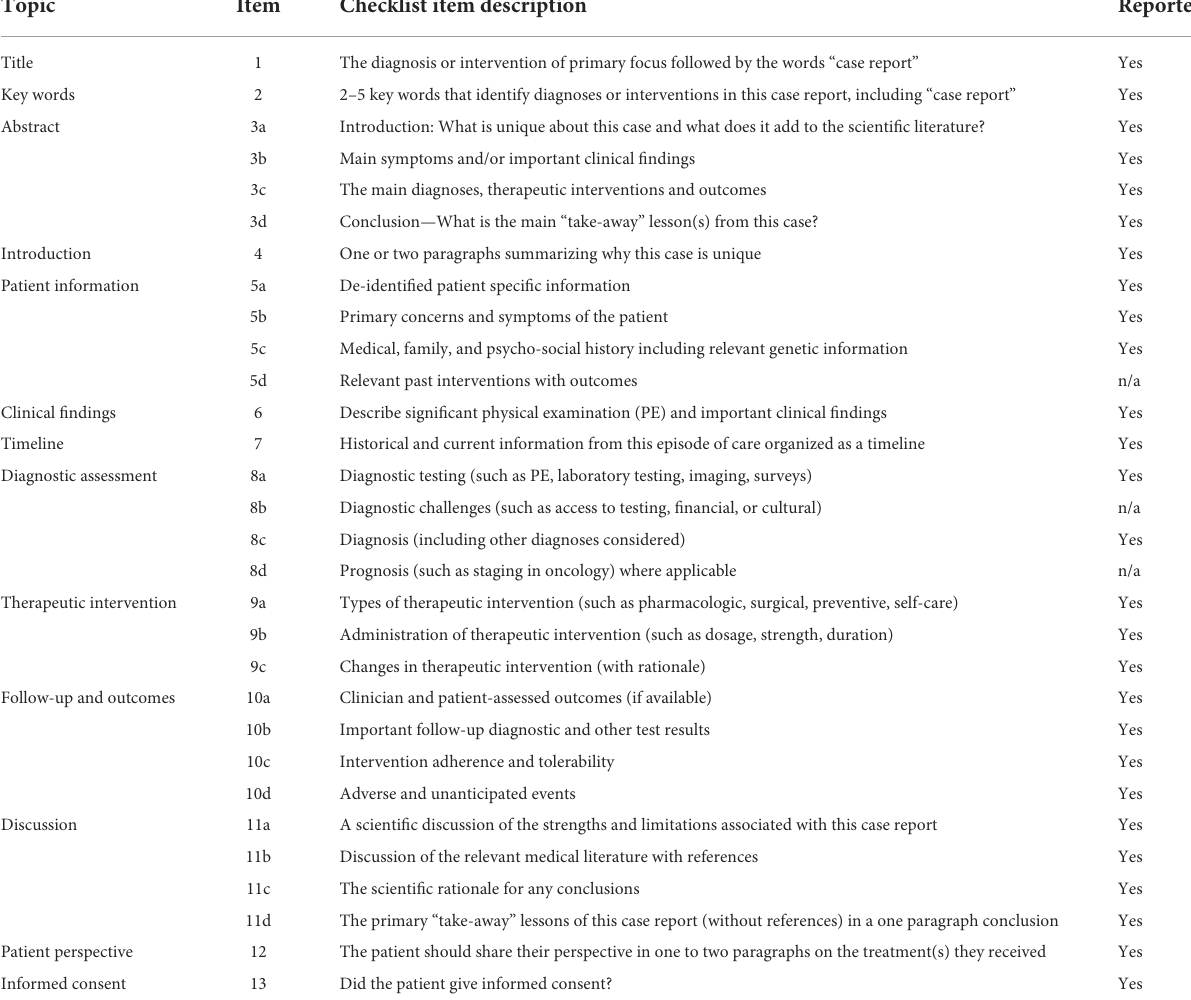
TABLE 3 CARE case report